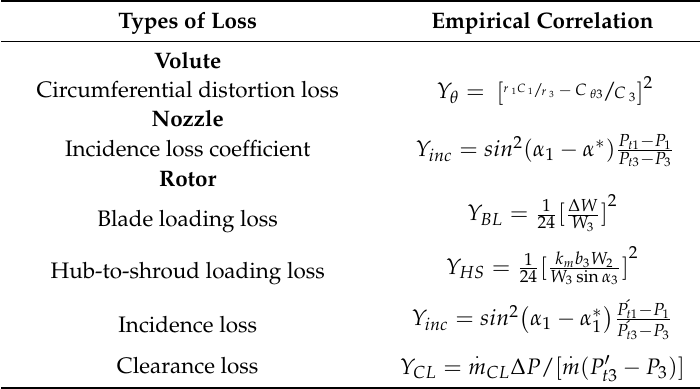
Table 3. Loss models used in the mean-line analysis.